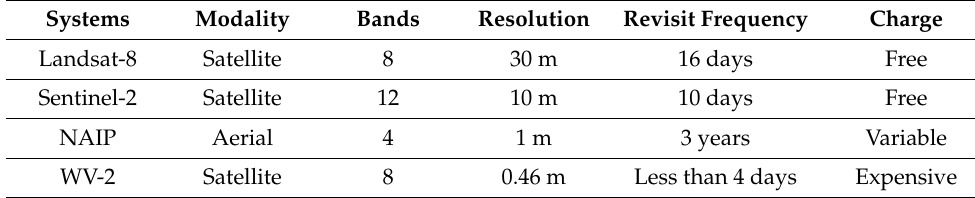
Table 1. Specifications of datasets used in the study.